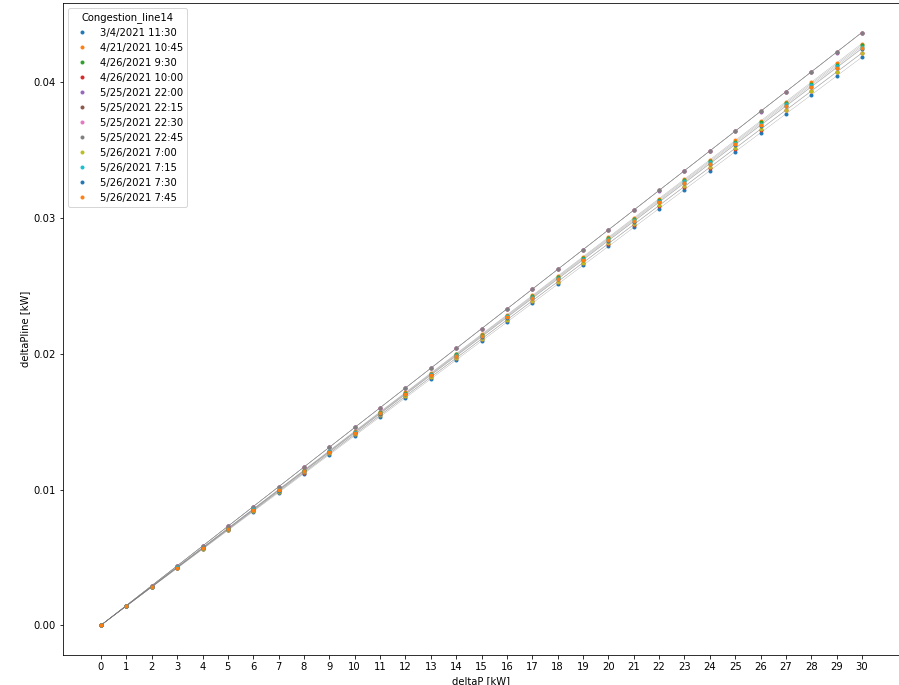
Figure 8. Dependences of change in loading of line 14 on changes in loading of consumer node 30 (Cons30) for different grid states.